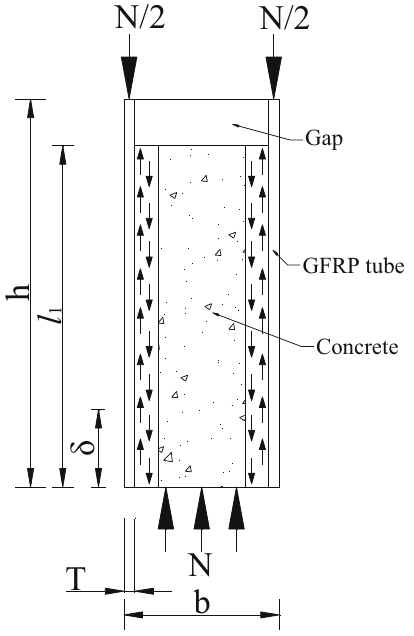
Figure 8: Diagrammatic sketch of stress of the